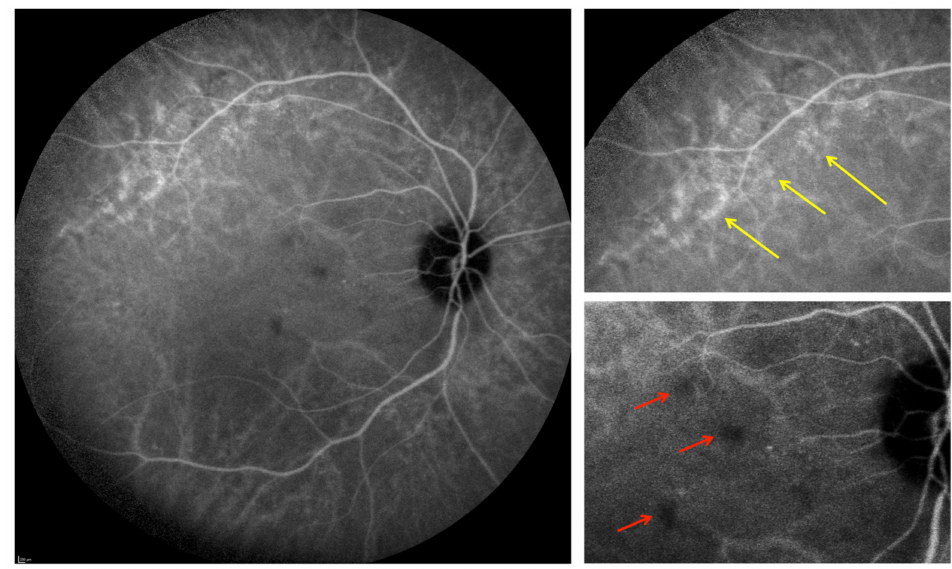
Figure 2. Intermediate phase of indocyanine green angiography showing dilated choroidal vessels with pinpoints (yellow arrows) and multiple hypofluorescent spots (red arrows).